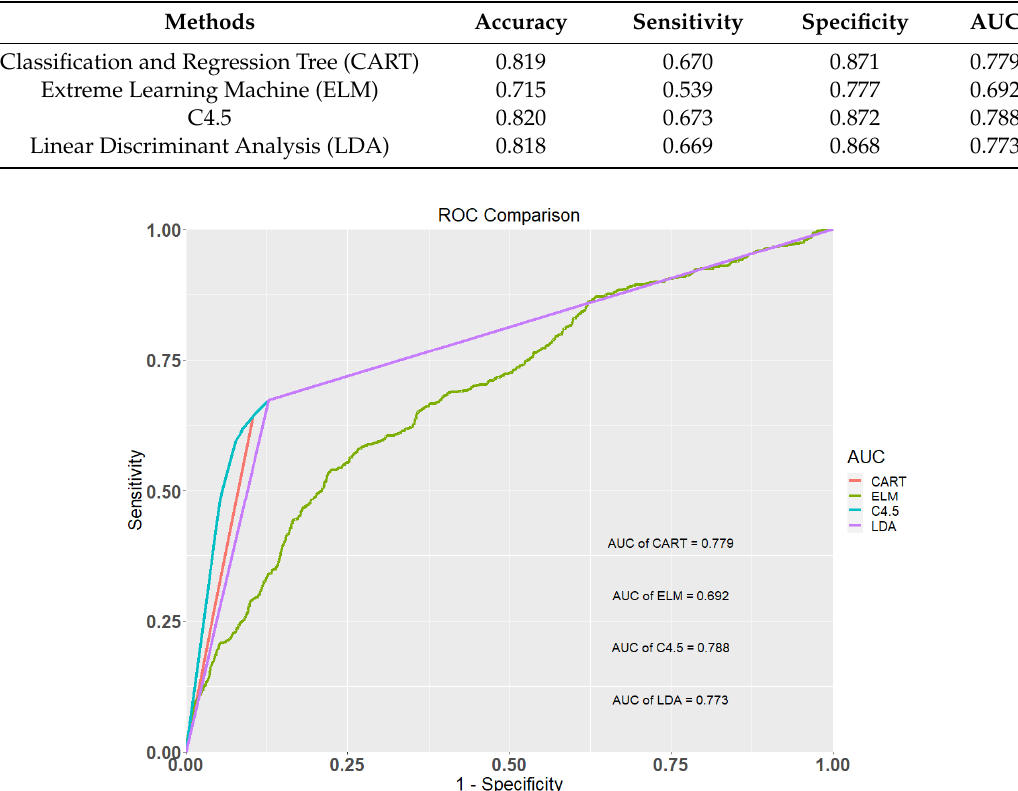
Table 4. Classification results of the four methods.